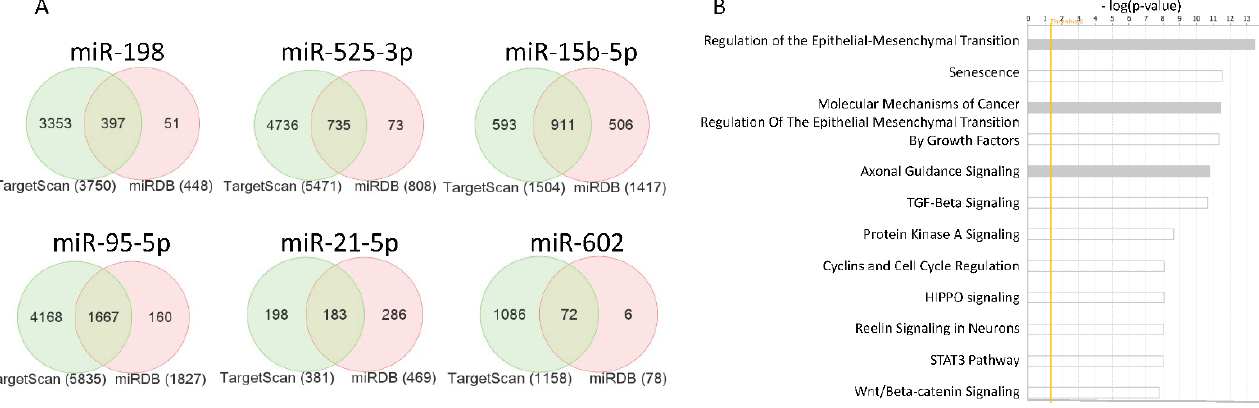
Figure 2. Venn diagrams of the target genes identified by TargetScan and miRDB for the six most significant miRNAs ( A ). Top canonical pathway identified on IPA from the list of the target genes in the intersections of the Venn diagram of the six most significant miRNAs ( B ). The significance values ( p -value of overlap) for the canonical pathways are calculated by the right-tailed Fisher’s Exact Test. The x-axis displays the -log of the p -value. The orange line indicates the significance threshold. Gray bars indicate pathways for which no prediction of activation or inhibition can be made due to insufficient evidence in the Knowledge Base for confident activity predictions across datasets. White bars indicate pathways with z-scores at or very close to 0.